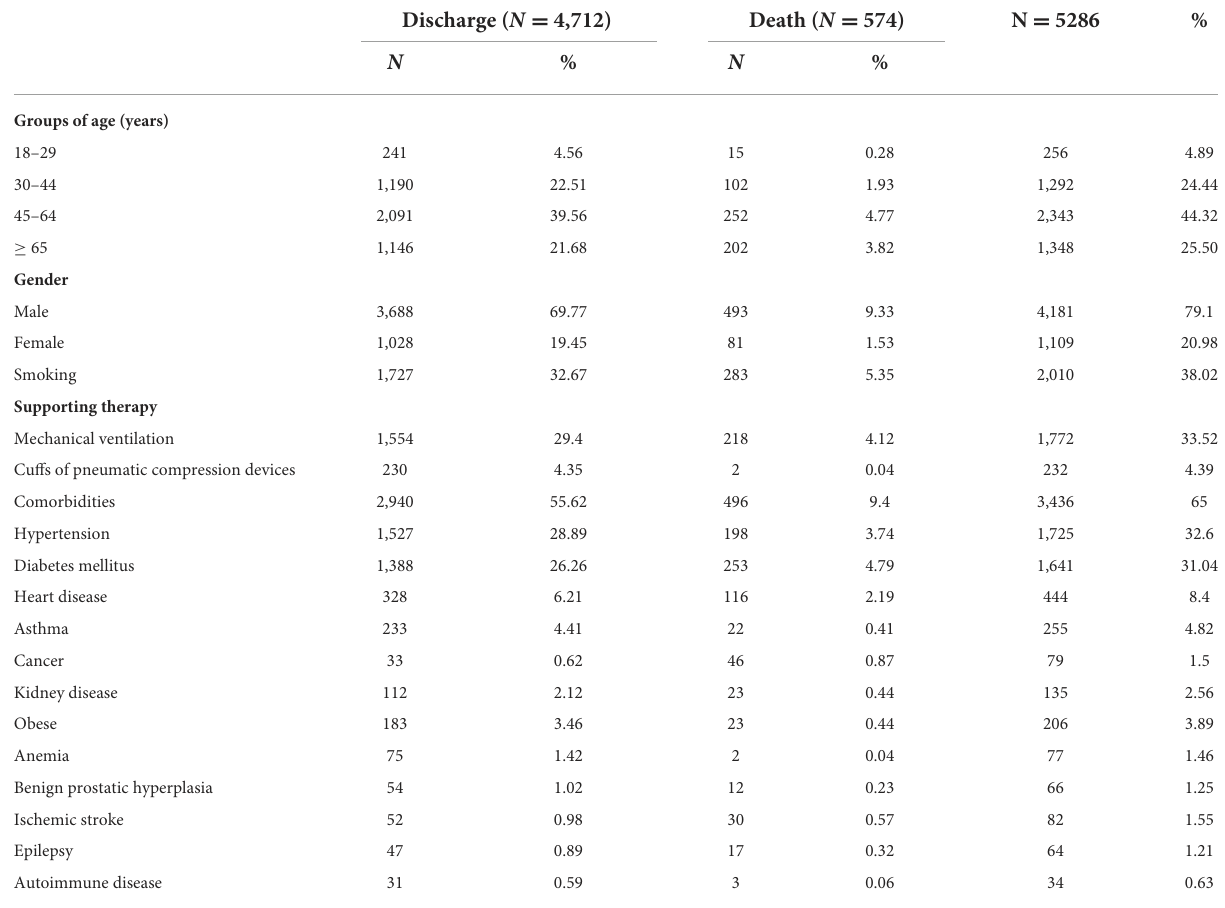
TABLE 1 Basic characteristics of patients hospitalized with